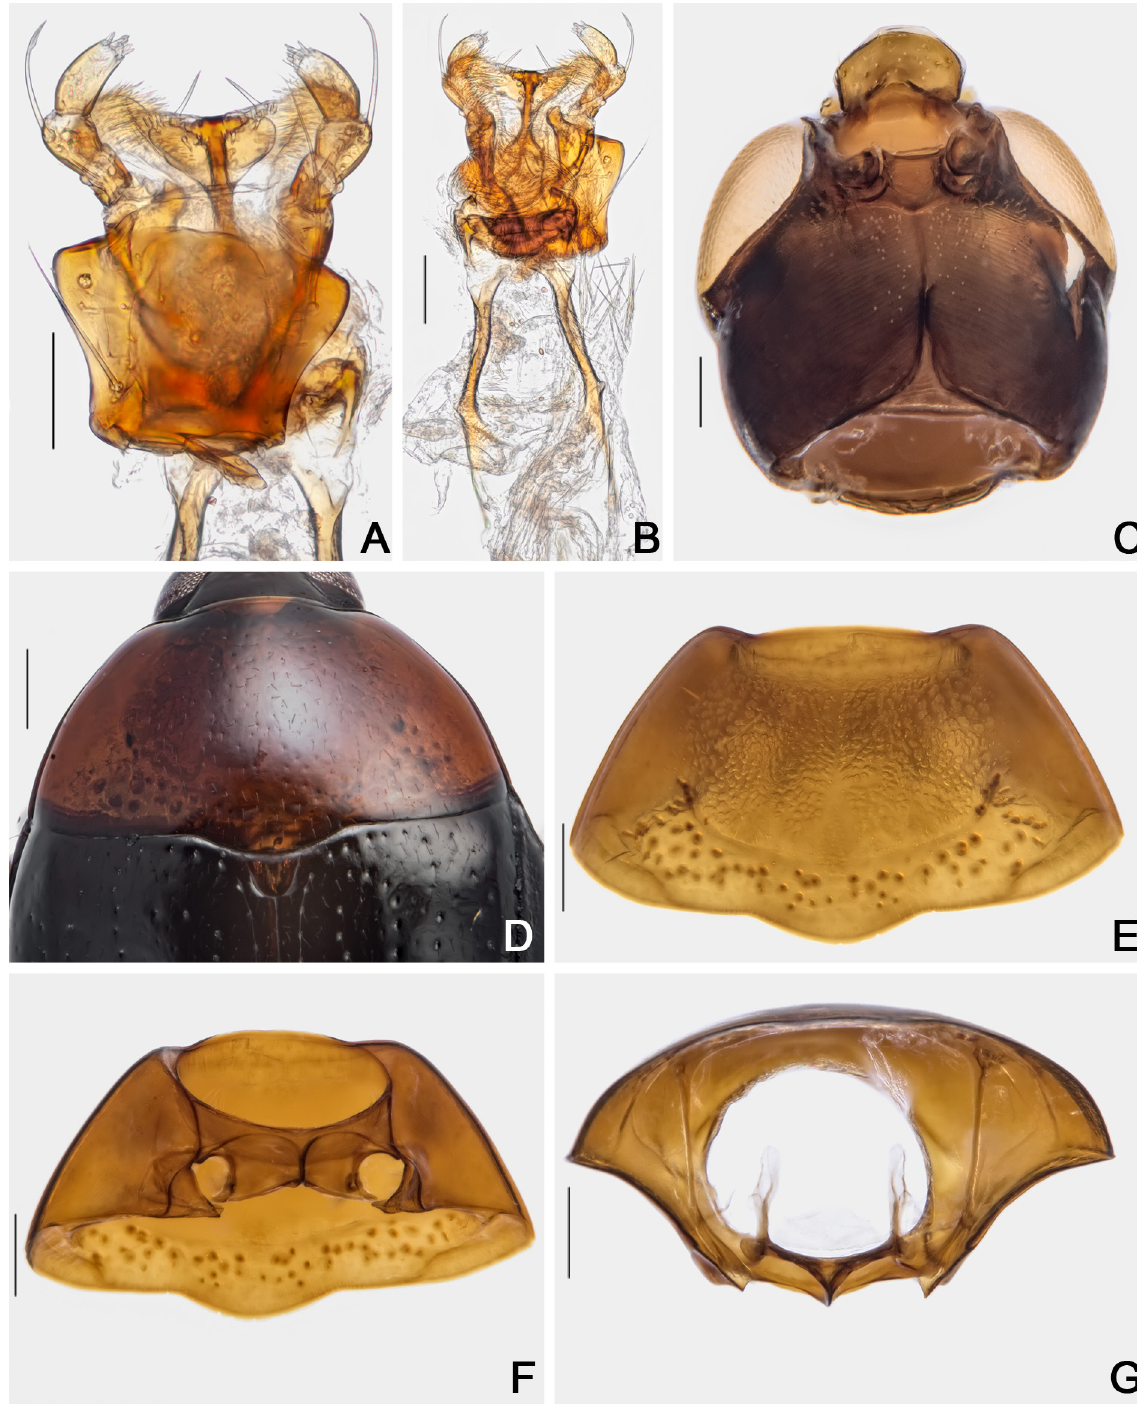
Fig. 32. Cyparium newtoni sp. nov. A–C, E–G . Paratype, ♂ (CELC). A . Labium. B . Hypopharynx. C . Head, ventral view. D . Holotype, ♂ (CELC), pronotum, dorsal view. E–G . Prothorax. E . Dorsal view. F . Ventral view. G . Inner view. Specimens collected at Mata da Biologia (A–C) and Mata do Paraíso (D–G), Viçosa (MG, Brazil). Scale bars: A–B = 0.05 mm; C = 0.1 mm; D–G = 0.2